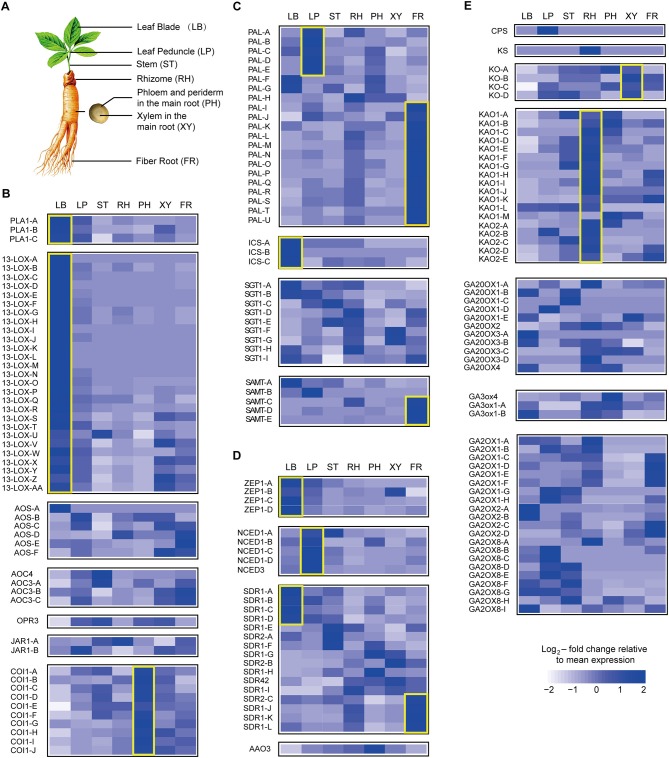
Expression pattern of hormone metabolism-related genes. Relative expression of selected genes responsible for key steps in the metabolism of seven plant hormones is shown using heatmap representations. The different tissues of ginseng are shown in (A). Panels show jasmonate (JA) (B), salicylic acid (SA) (C), abscisic acid (ABA) (D), and gibberellin (GA) (E) metabolism. Each column represents one tissue (LB, leaf blade; LP, leaf peduncle; ST, stem; RH, rhizome; XY, xylem in the main root; PH, phloem and periderm in the main root; FR, fibrous root) and each row represents one unigene corresponding in RNA-seq data (Supplementary Table S2). Different unigene labels might match to one annotated gene here due to the same specific sequence regions or domains. Colors show Z-score transformed gene expression values among all samples. Genes are grouped according to gene families or metabolic functions. Genes mentioned in the manuscript are highlighted with yellow boxes.